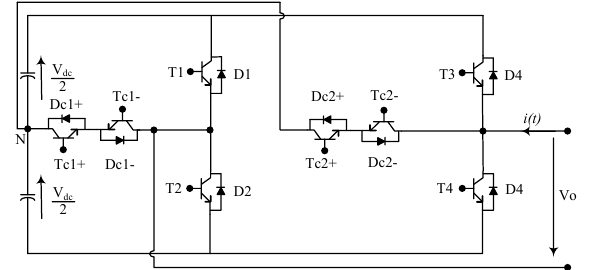
Fig. 2 HB-T-type five level